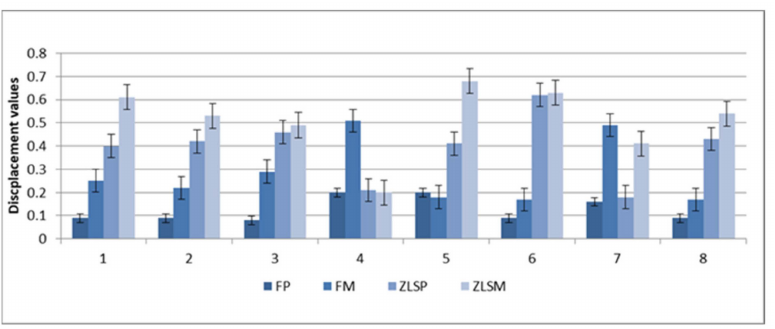
Figure 3. Mean maximal displacement values for the heat-pressed samples FP, ZLSP, and milled FM,